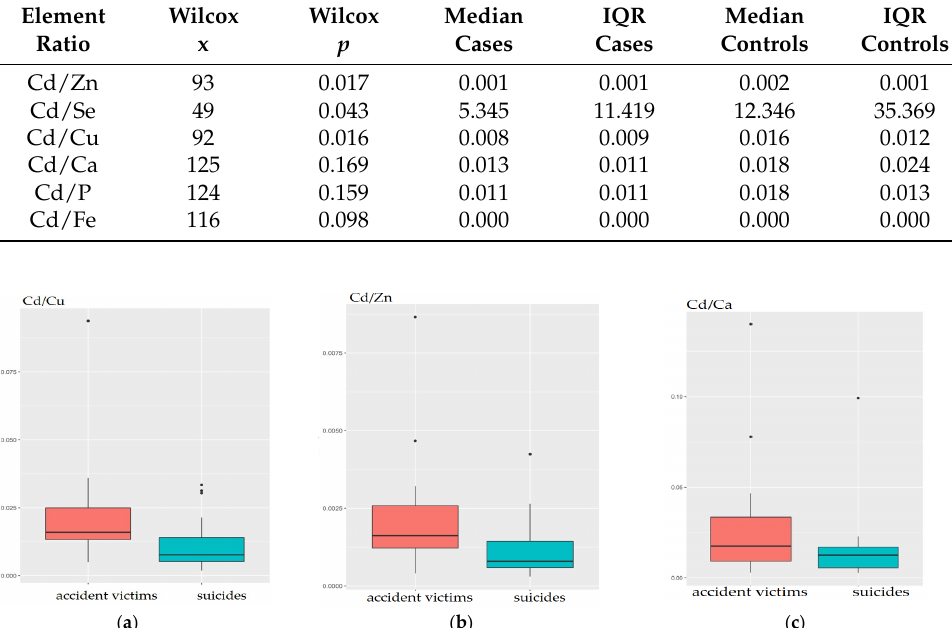
Figure 3. Statistically significant differences in Cd/Cu ( a ), Cd/Zn ( b ), Cd/Ca ( c ) ratios in the arach- noid of suicides (cases) in comparison to the accident victims